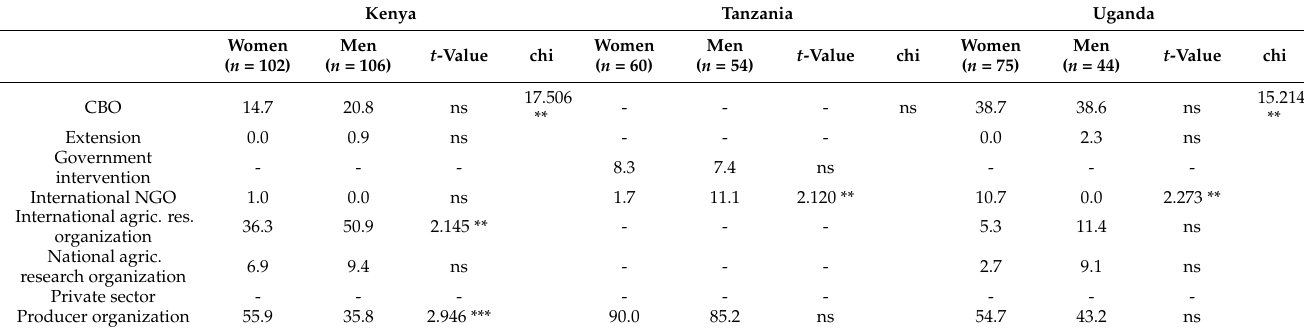
Table A4. Formal sources of seed (% of respondents)—statistical tests for results presented in Figure 3. Kenya